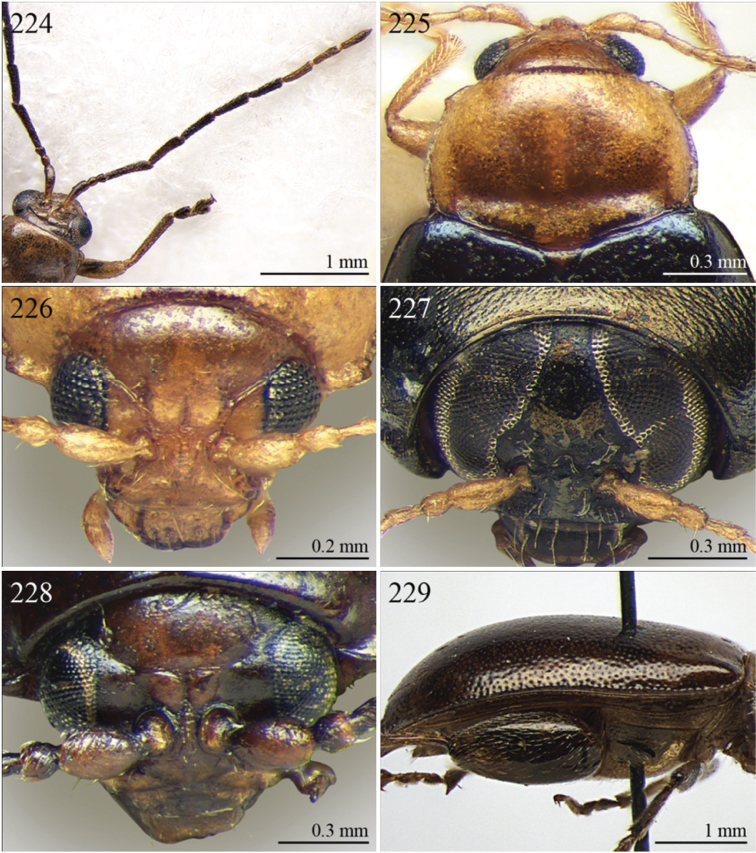
Morphological characters. 224
Nzerekorena filicornis Scherer & Boppré, head and right antenna in dorsal view 225
Orthocrepis kibonotensis (Weise), head and pronotum in lateral view 226 Ditto, head in frontal view 227
Paradibolia abdominalis (Jacoby), head in frontal view 228
Perichilona bicolor Weise, head in frontal view 229
Philopona sulcicollis (Jacoby), elytra in lateral view.